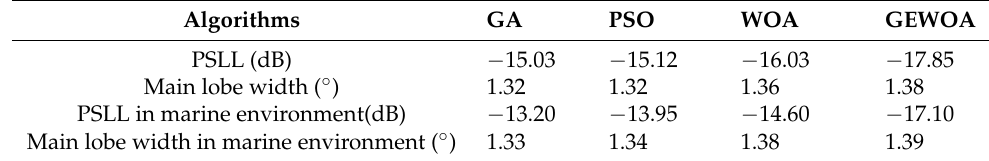
Table 4. The PSLLs of arrays designed using different